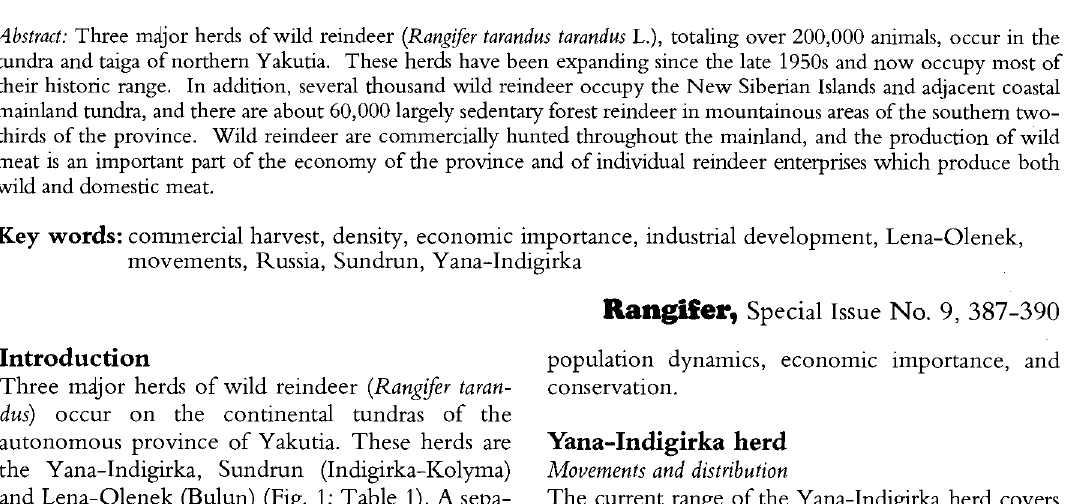
Table 1. Estimated' size (thousands of animals) of the